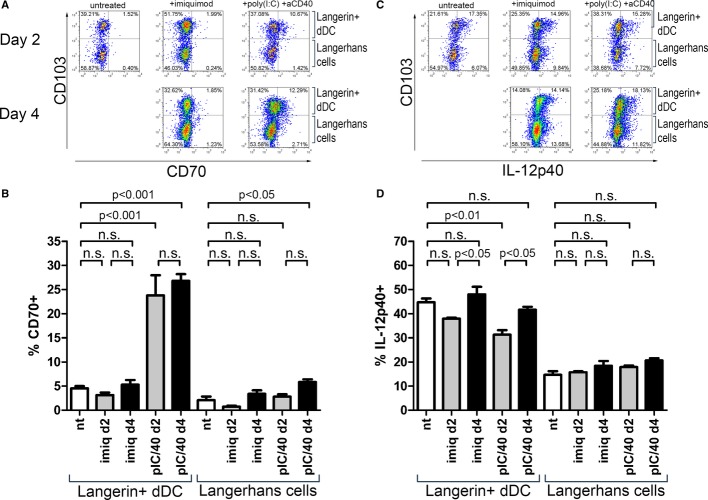
Langerin+ dDCs, but not LCs, express CD70 upon pIC/40 stimulation in vivoBoth ears of C57BL/6 mice were treated with imiquimod (imiq), poly(I:C) and anti-CD40 (pIC/40), or left untreated (nt). Two or 4 days later, a cell suspension was obtained from four auricular lymph nodes collected from two identically treated mice, and expression of CD70 and IL-12p40 was evaluated by flow cytometry. Measurements, each comprising cells from two mice, are pooled from two independent experiments (nt: n = 7; imiq—day 2: n = 4; imiq—day 4: n = 4; pIC/40—day 2: n = 4; pIC/40—day 4: n = 3) and compared using one-way ANOVA followed by Tukey's test (n.s., non-significant, P > 0.05).Representative stainings showing surface expression of CD70 in CD11c+ Langerin+ DCs.Percentages of Langerin+ dDCs and LCs expressing CD70 (ANOVA: P < 0.0001 and P = 0.0003, respectively).Representative stainings showing intracellular expression of IL-12p40 in CD11c+ Langerin+ DCs after a 3-h incubation with Brefeldin A.Percentages of Langerin+ dDCs and LCs expressing IL-12p40 (ANOVA: P = 0.0008 and P = 0.0995, respectively).